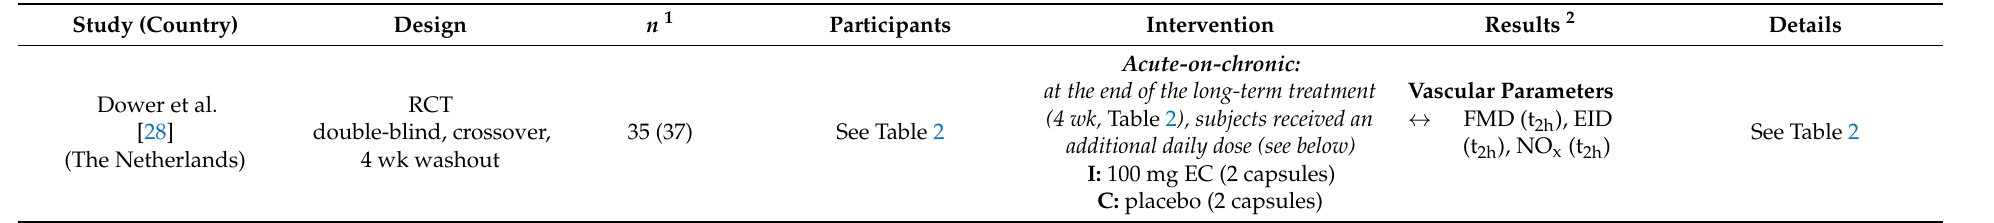
Table 3. Effect of an acute (–)-epicatechin intake following a regular ingestion of (–)-epicatechin on cardiometabolic parameters—results from randomized controlled